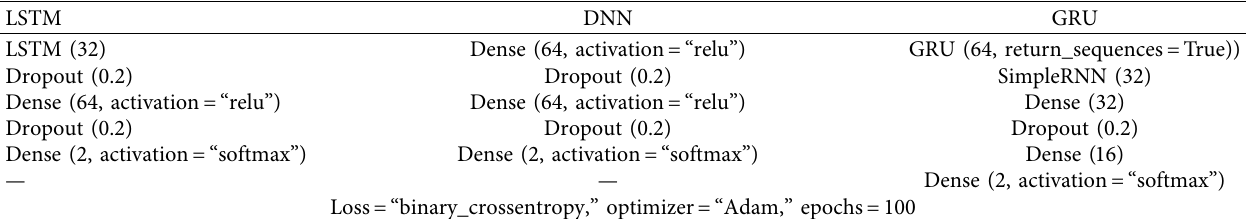
Table 14: Architecture of LSTM, DNN, and GRU used for